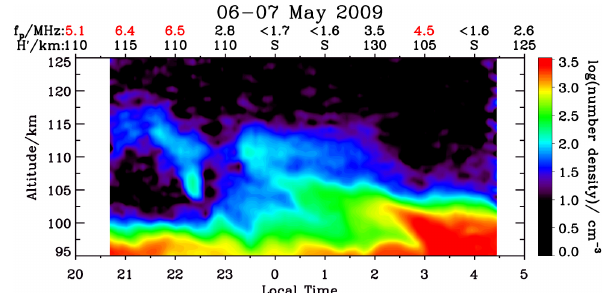
Figure 7. Na density contour plot and E s layer parameters during the night of 6–7 May 2009, which displayed a high-altitude Na s layer above 105km. Notice the correlation between the Na s and E s layer events on this night seemed